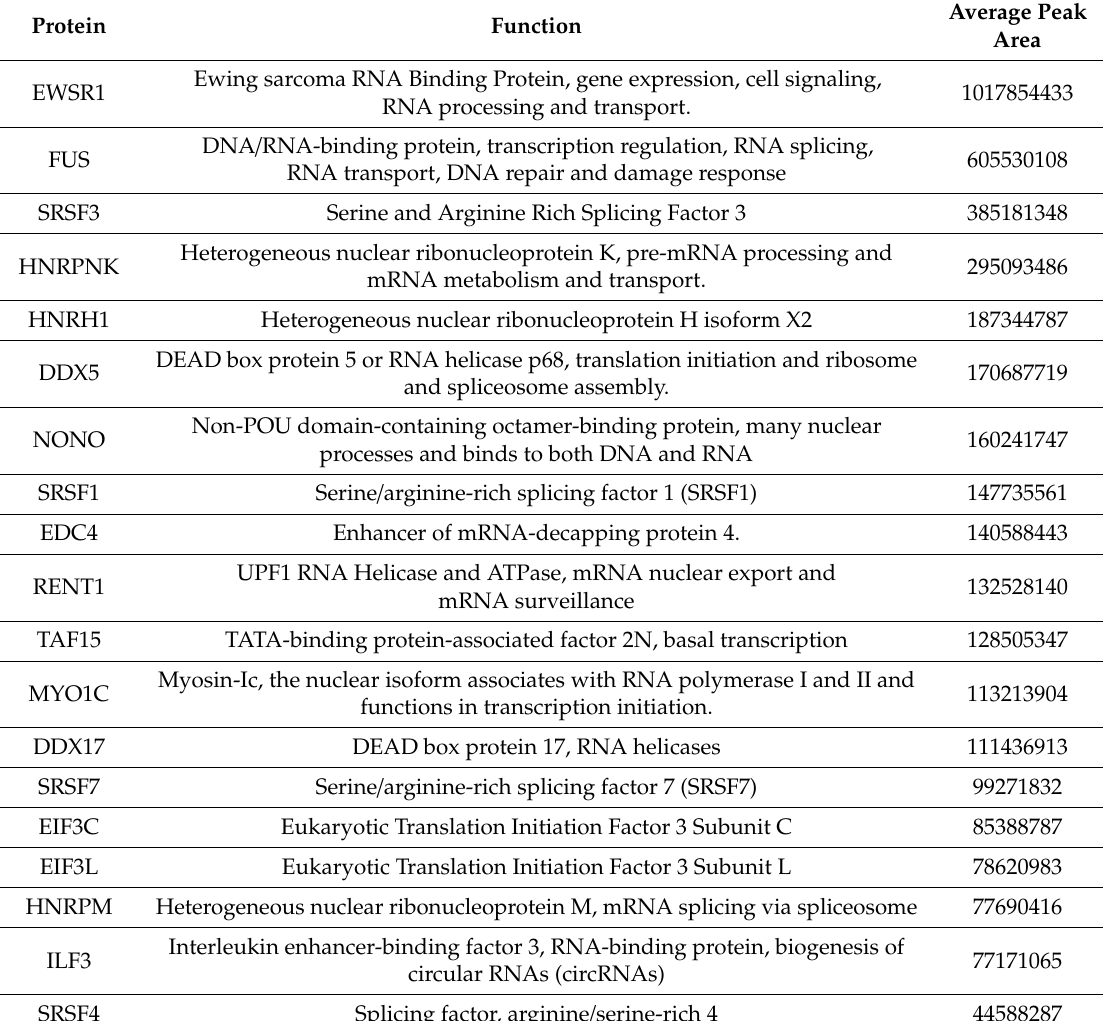
Table 2. The table represents interacting proteins of SDC1 having higher peak area values. The values were rounded o ff to the nearest whole number.